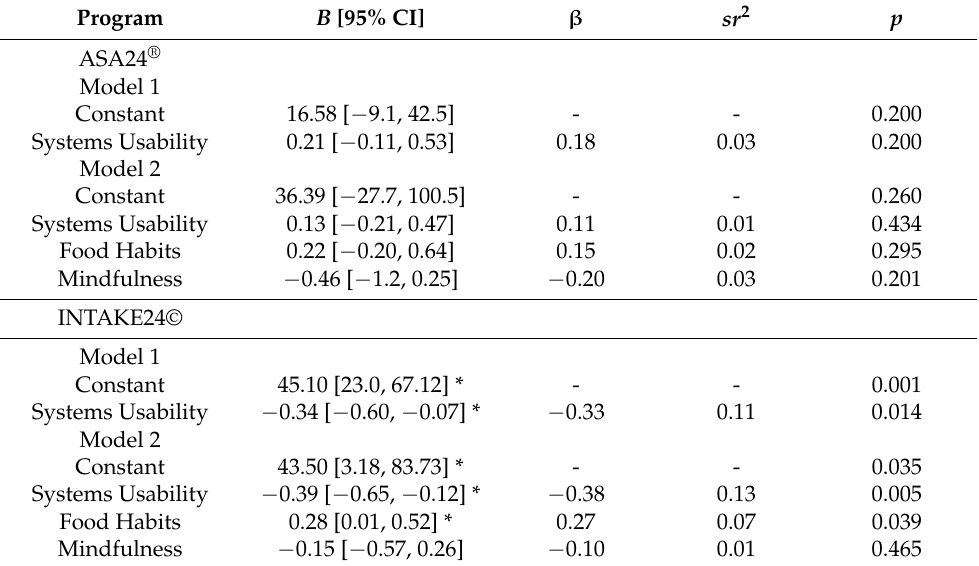
Table 5. Standardised ( β ) and Unstandardised ( B ) Regression Coefficients and Squared Semi-Partial Correlations ( sr 2 ) for Variables Predicting Overall Perceived Problems Associated with ASA24 ® and INTAKE24© During 24-hour Dietary Recall Using Hierarchical Multiple Regression Analysis ( N =